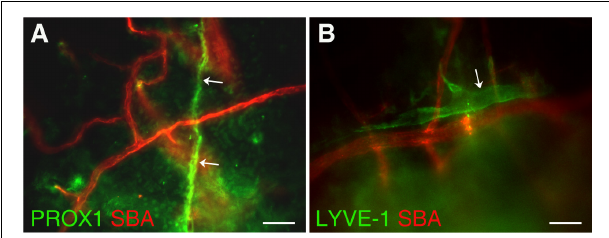
FIGURE 2 | Presence of lymphatic vessels of differing sizes and degrees of association with meningeal blood vasculature. (A) Lymphatic microvessel (Prox-1, green, white arrows) ∼ 5 µ m in diameter exhibiting no apparent association with blood vessels (SBA lectin, red). (B) Lymphatic vessel (LYVE-1, green, white arrow) ∼ 25 µ m in diameter runing along side an ∼ 20–25 µ m diameter arteriole (SBA lectin, red). In panel (A) Prox1 eGFP mice, in which lymphatic vessels exhibit bright green fluorescence, the hearts were injected with Kreb’s/albumin solution containing AlexaFluor 594-conjugated SBA lectin to visualize the systemic blood vasculature. In (B) wild type C57BL/6J mice were perfused through the heart with Kreb’s/albumin solution containing AlexaFluor 488-conjugated anti-mouse Lyve-1 antibody and AlexaFluor 594-conjugated SBA lectin to visualize lymphatic and blood vasculatures, respectively. In (A,B) the images, acquired using spinning disk confocal microscopy, are the sum slices of the Z stack projection. Scale bars, 50 µ m.